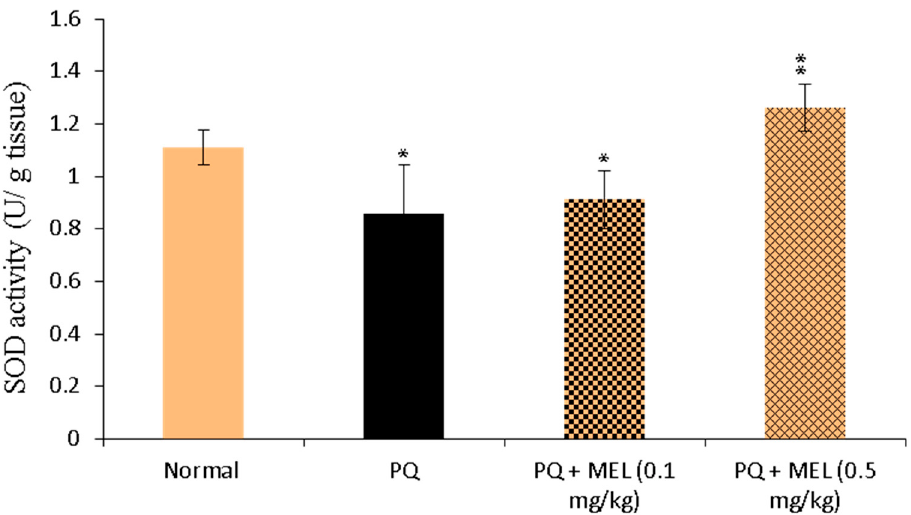
Figure 4. Effect of treatment with melittin (MEL) on superoxide dismutase (SOD) activity in lung tissue homogenate. SOD activity was measured according to Beyer method, using SOD colorimetric assay. SOD activity was measured and expressed as U/g tissue. Data are presented as mean ±SD. Significantly (* p < 0.05, ** p < 0.01) different from PQ group.